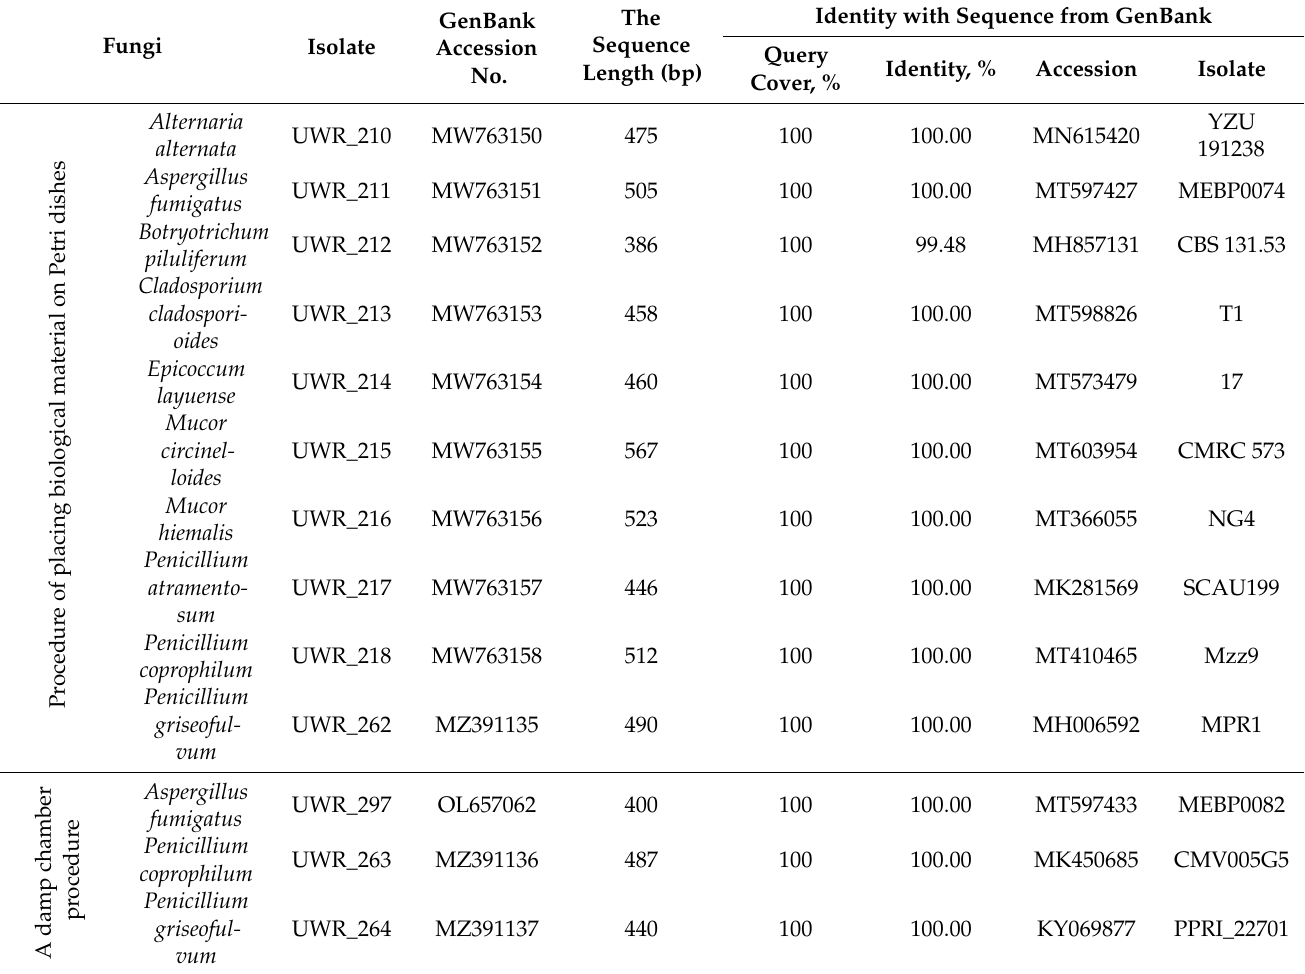
Table 1. BLAST analysis of rDNA ITS of fungi associated with grey heron ( Ardea cinerea ) nests or insects ( Leptoglossus occidentalis ) inhabiting the nests. All E values were equal to